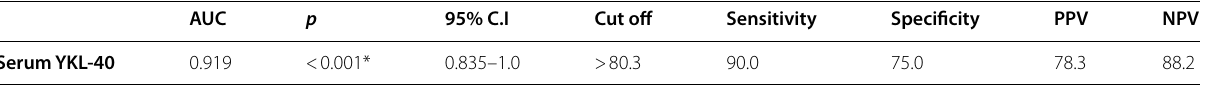
20) from group I ( n 20) = =